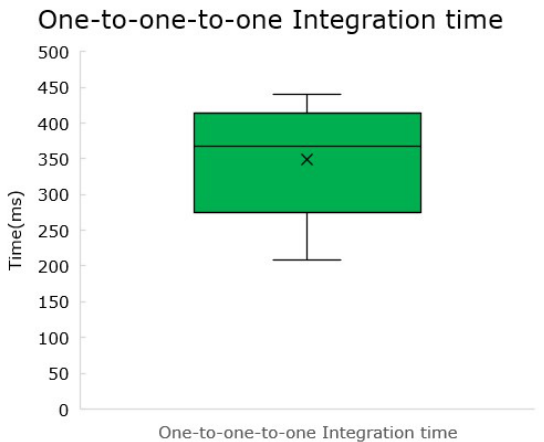
Figure 16. Integration time of the one-to-one-to-one